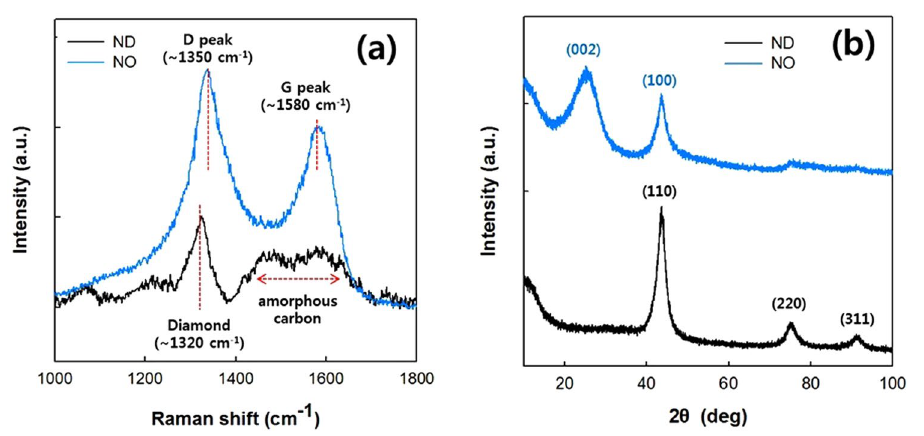
Figure 2. ( a ) Raman spectra and ( b ) XRD patterns of the ND and NO